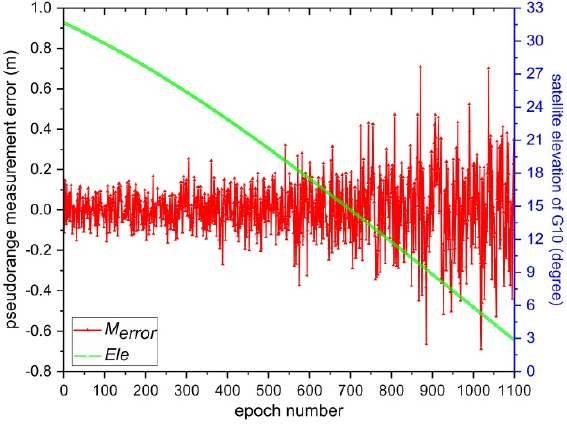
Figure 7. Elevation and pseudorange measurement error sequence of satellite G10.